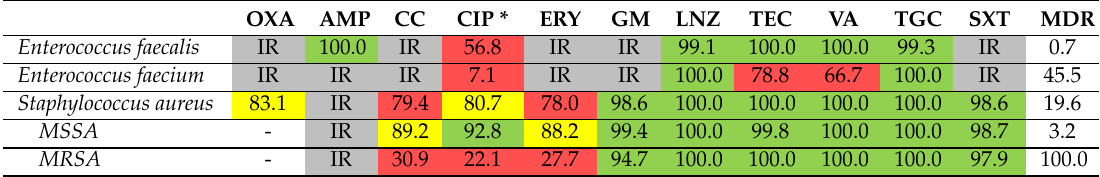
Table 4. Rates of susceptibility and multi-drug resistance for Gram-positive ESKAPE